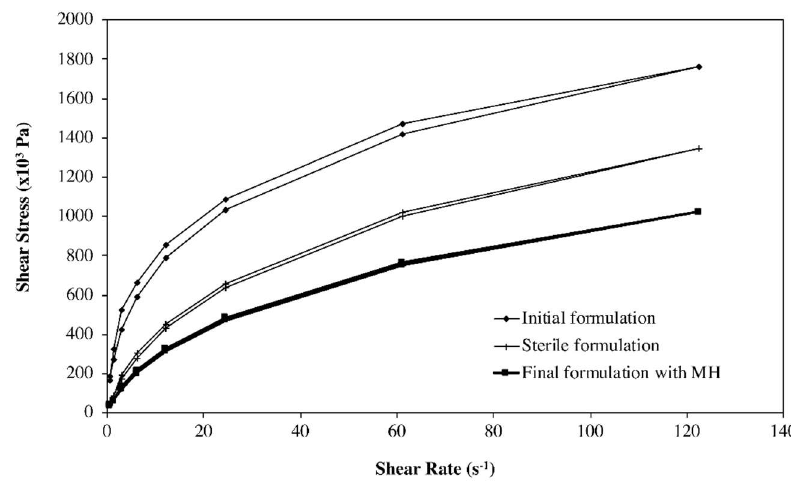
Figure 3. Flow curves of NaCMC gels (3%), before autoclaving ( (cid:7) ), after autoclaving ( + ) and after MH incorporation ( (cid:4) ).